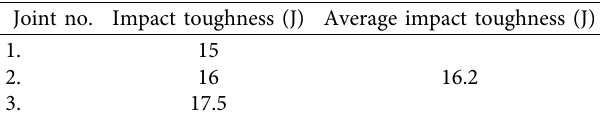
Figure 15: Macrograph of fractured sample after the impact toughness test: (a) front view; (b) cross-sectional view. Table 6: Impact toughness test results of joints.